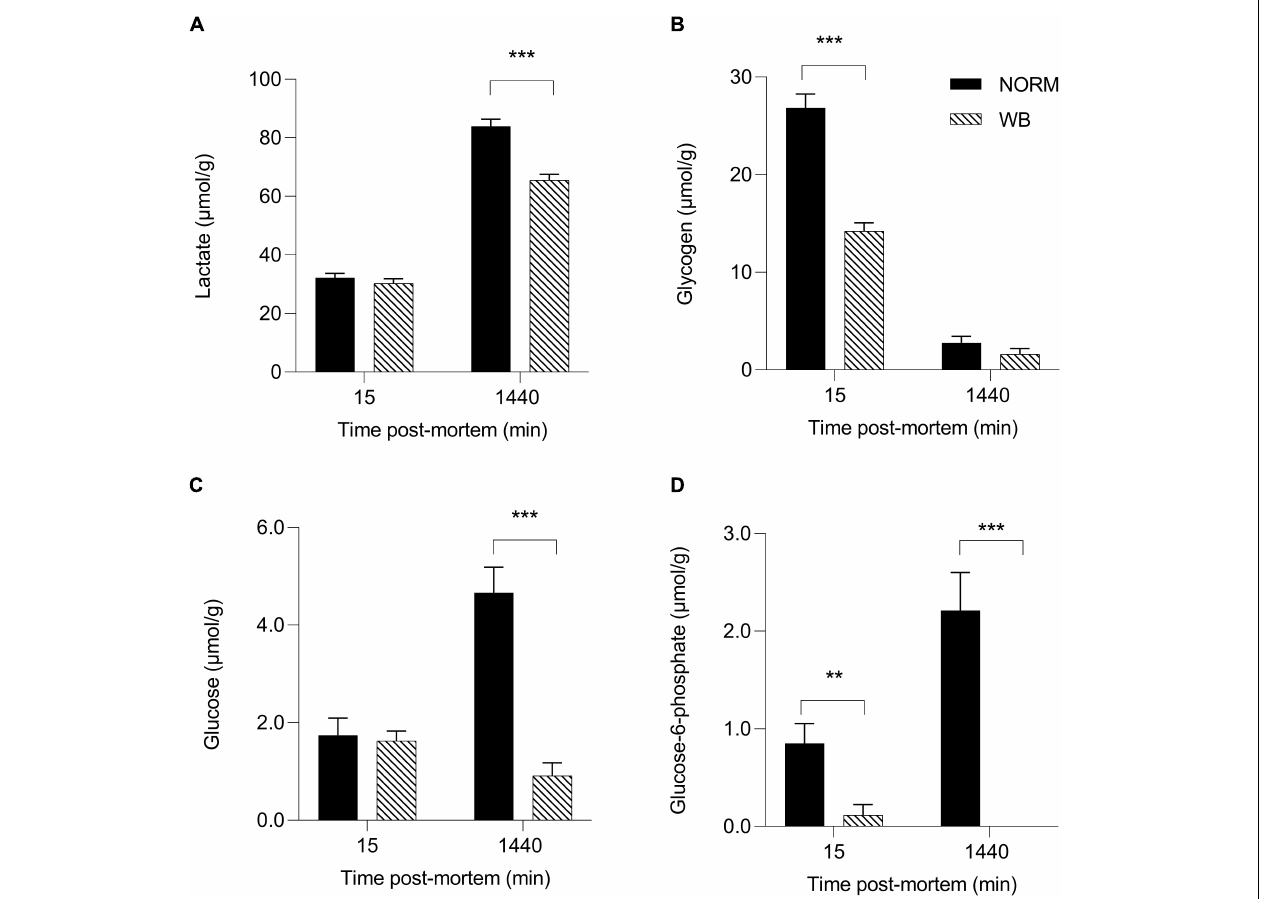
FIGURE 3 | Average lactate ( A , µ mol/g), glycogen ( B , µ mol/g), glucose ( C , µ mol/g), and glucose-6-phosphate ( D , µ mol/g) of unaffected (NORM) and wooden breast (WB) broiler pectoralis major muscles ( n = 12/group) at 15 and 1,440 min post-mortem. Data represent means ± SEM. Asterisks indicate a significant difference within the time point (*** P < 0.001; ** P <